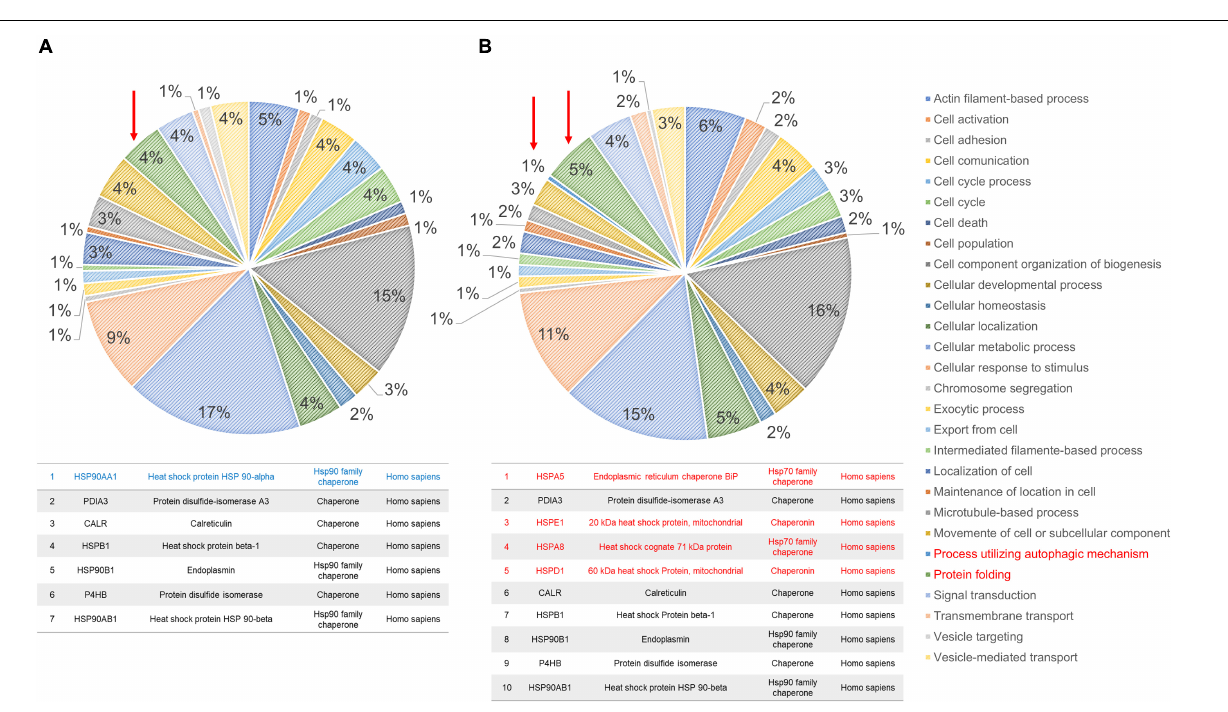
Frontiers in Aging Neuroscience |